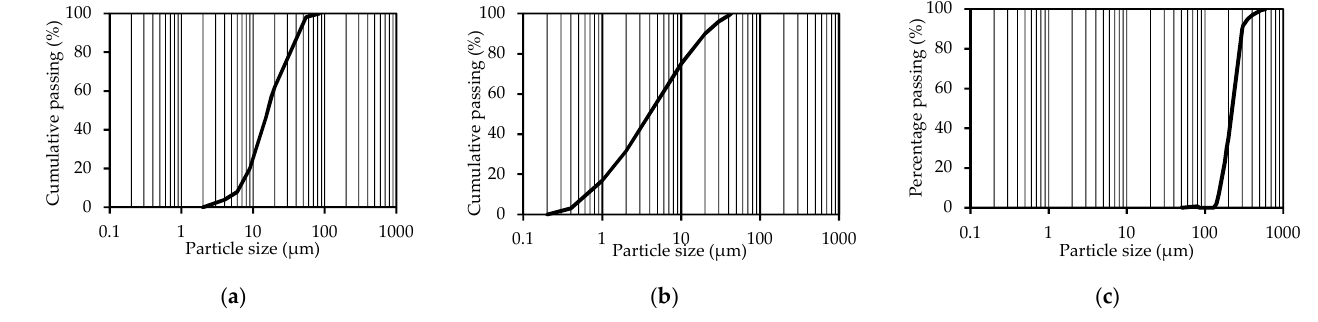
Figure 4. Particle size distribution of ( a ) slag, ( b ) fly ash, and ( c ) dune sand. Table 2. Physical properties of natural aggregates (NA).